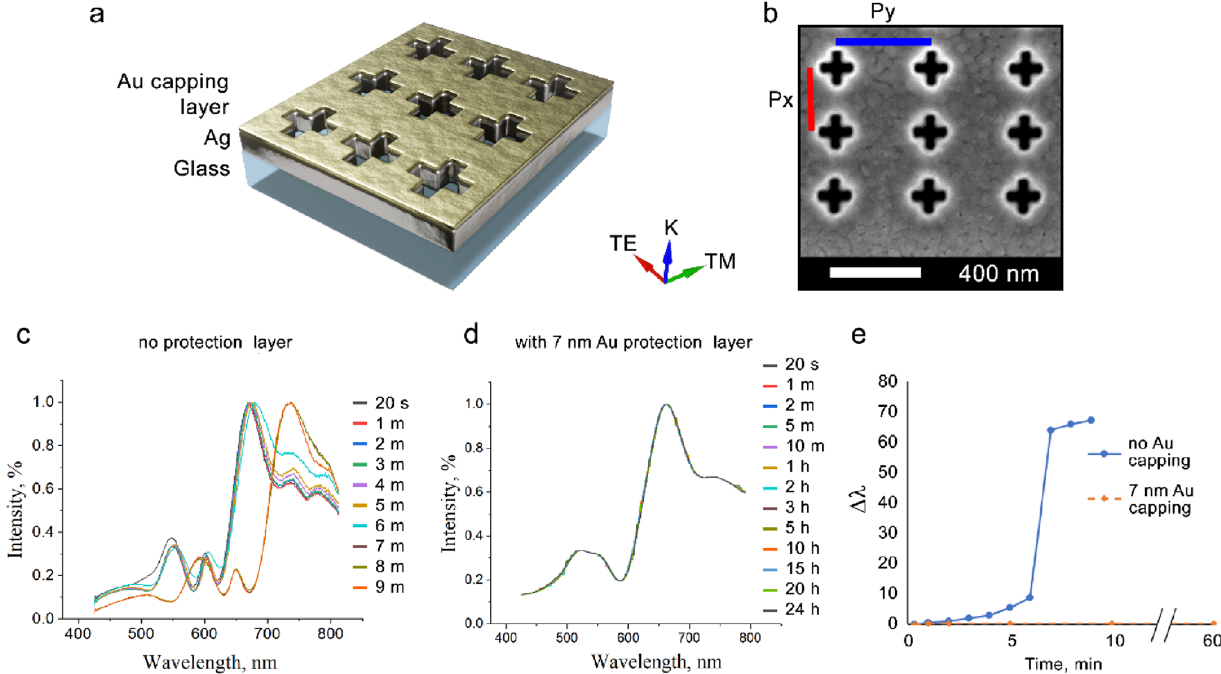
Figure 1. ( a ) A schematic device design and configuration. ( b ) SEM image of the cross-shaped apertures. Px (red line) and Py (blue line) indicate the array periodicities in the X and Y directions respectively. The width and the length of the arms of the cross-shaped apertures are 50 and 160 nm respectively. Transmission spectra for ( c ) a bare Ag plasmonic device and d) a device covered with a 7 nm Au film immersed in ethanol solution. ( e ) The corresponding shift in the main plasmon resonance peak. Note that at 7 min there is a large jump in the main transmission peak position for the bare Ag device and hence the measurements were halted for the bare plasmonic after 10 min. For the device protected by 7 nm Au the shift in plasmon resonance peak position was found to be < 0.5 nm after 60 min. The devices were also left in ethanol overnight for a total of 24 h and then re-measured and, even then, no peak shifts greater than 0.5 nm were observed.